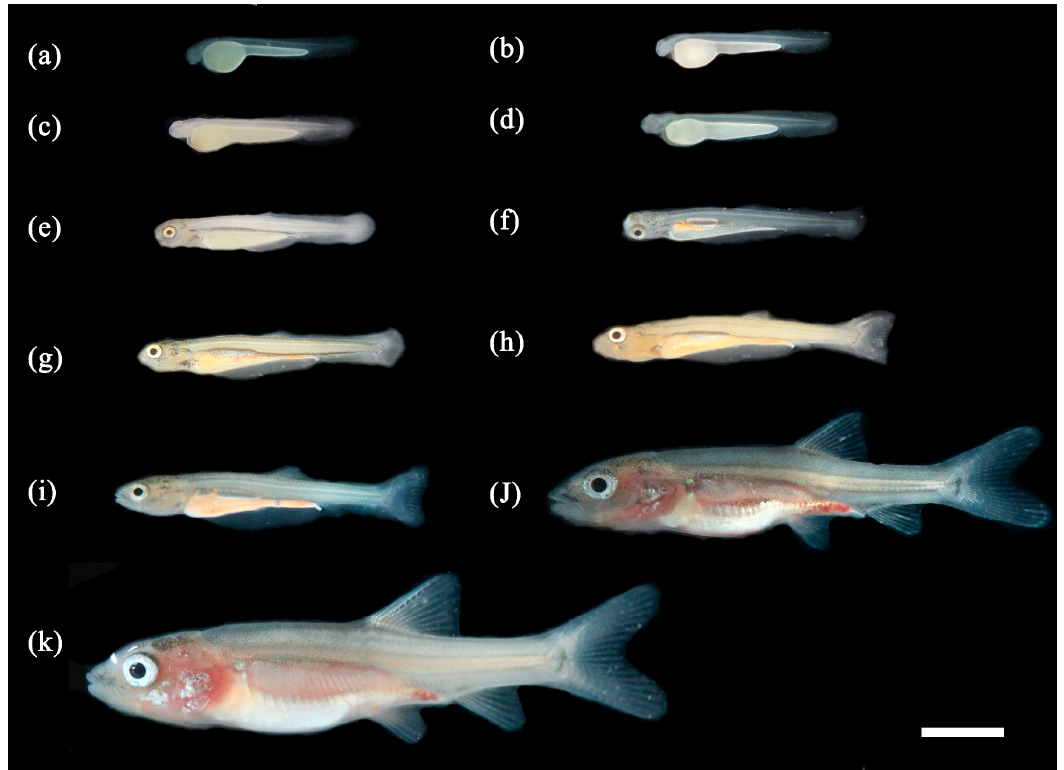
Figure 6. Morphological development of P. retrodorslis during larval and juvenile periods. Larvae at 0 DPHs, 10.29 mm TL ( a ); 1 DPHs, 10.43 mm TL ( b ); 3 DPHs, 11.04 mm TL ( c ) ; 5 DPHs, 11.79 mm TL ( d ); 8 DPHs, 13.15 mm TL ( e ); 14 DPHs, 14.48 mm TL ( f ); 18 DPHs 15.96, mm TL ( g ); 25 DPHs, 18.05 mm TL ( h ); 26 DPHs, 18.63 mm TL ( i ); 51 DPHs 30.07 mm TL ( j ); 60 DPHs 34.74 mm TL ( k ). Scale bars = 5 mm.